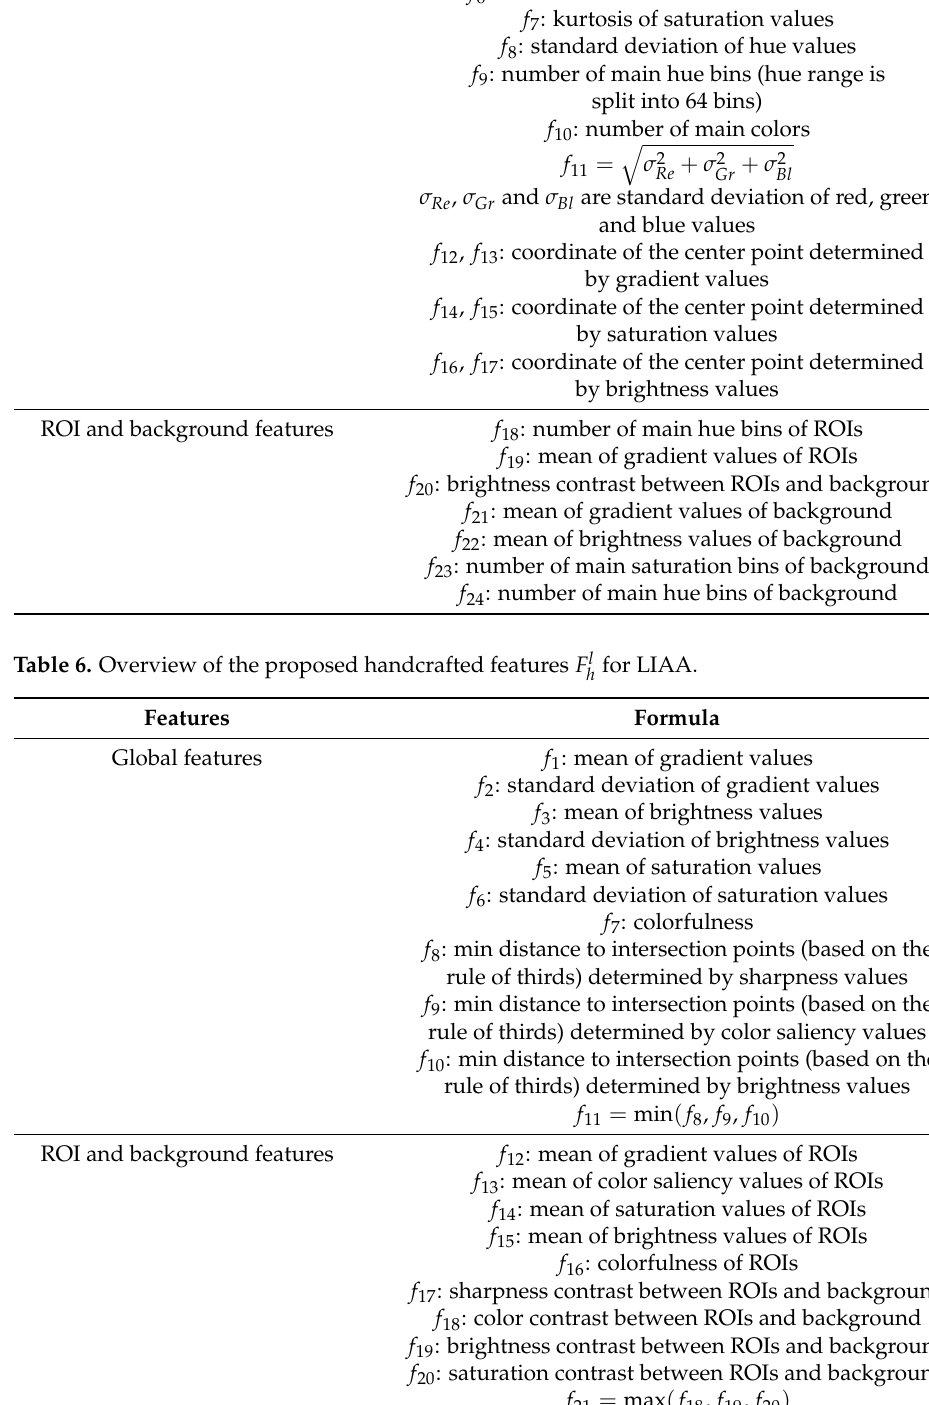
Table 5. Overview of the proposed handcrafted features F a